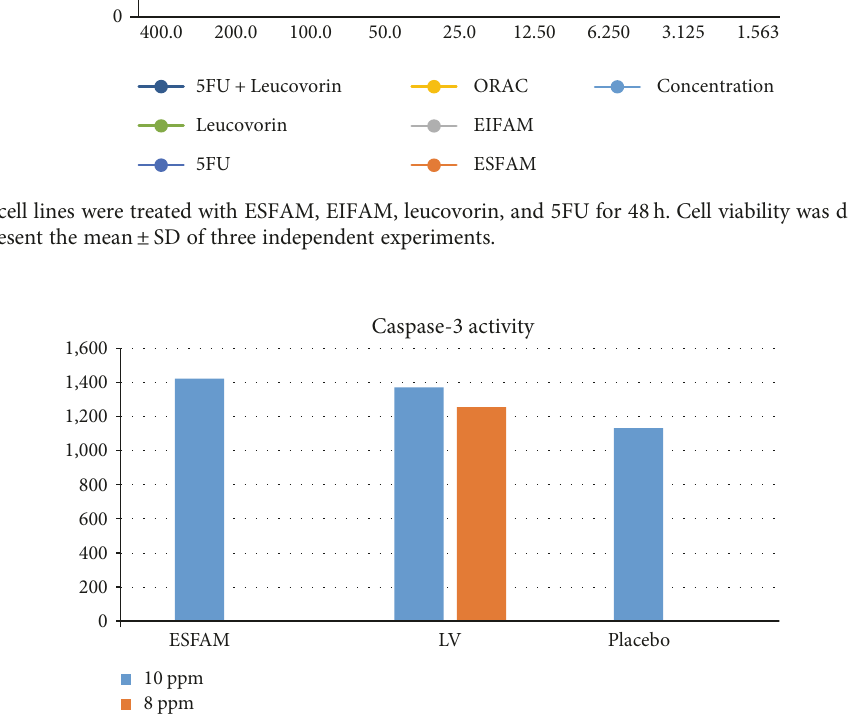
Figure 2: Caspase-3 activity of ESFAM, leucovorin, and placebo with 10ppm and 8ppm dosages. ESFAM extract gives a higher result at 10ppm dosage compared to that at 8 ppm